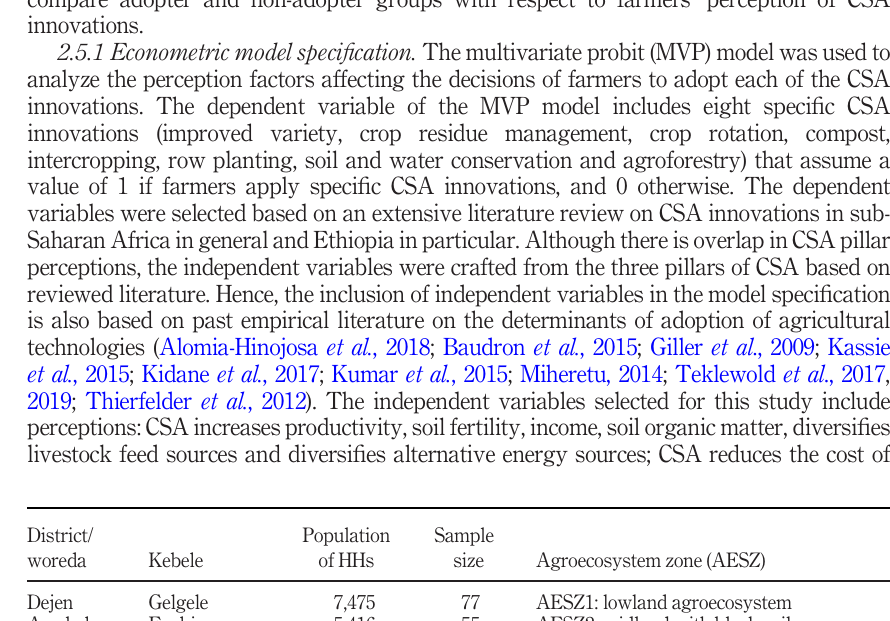
Table 1. Sample woredas/ districts and